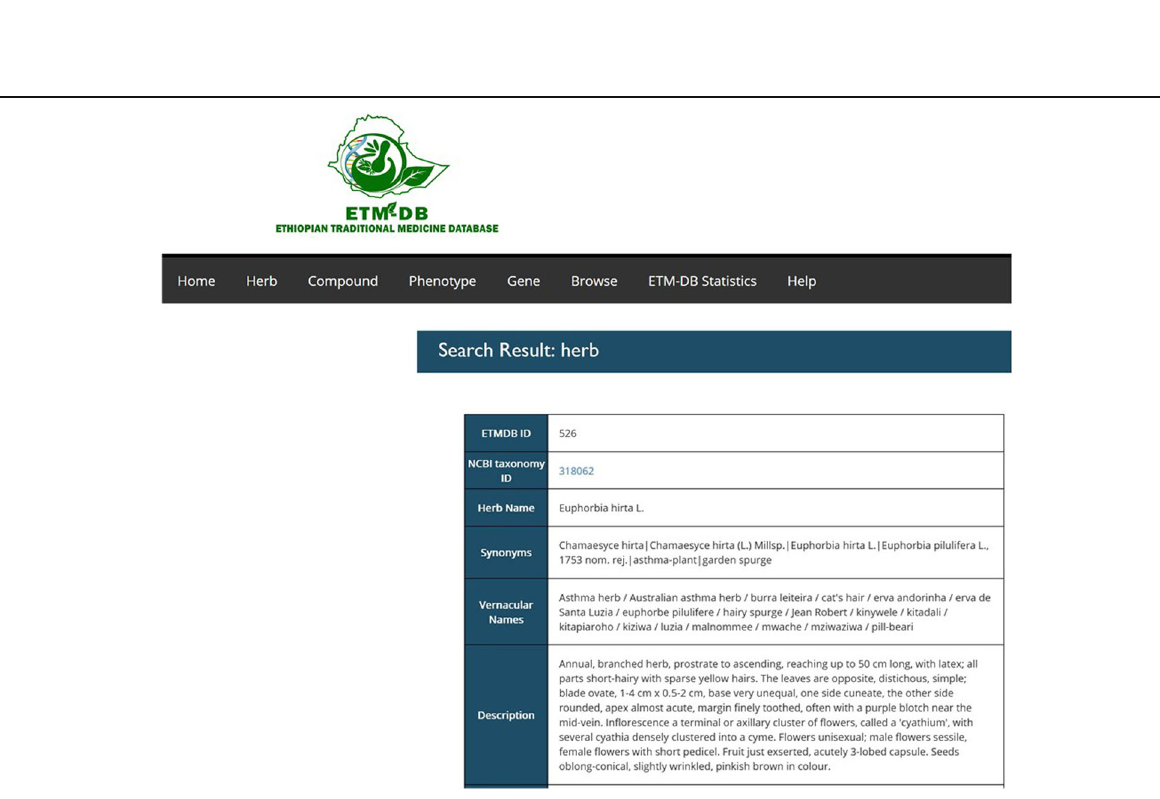
Fig. 3 Web interface of ETM-DB. Snapshot of part of query results for a medicinal herb